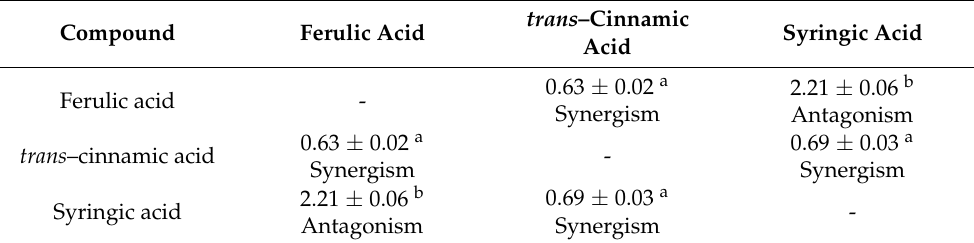
Figure 7. Dose-normalized isobolograms for chosen polyphenols with antiradical activity. ( A ) syryngic acid and ferulic acid, ( B ) trans -cinnamic acid and ferulic acid, ( C ) trans -cinnamic acid and syryngic acid). Table 6. Combination index (CI) value between mixtures consisting of two polyphenols on antiradical activity, n =